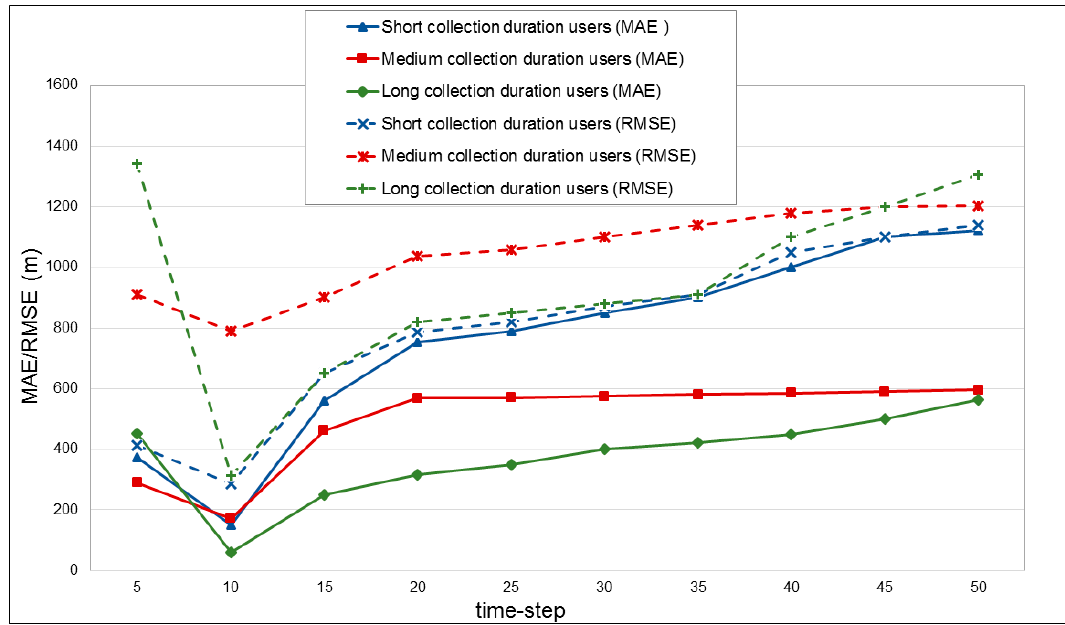
Figure 5. Comparison experimental results with different time-step windows.